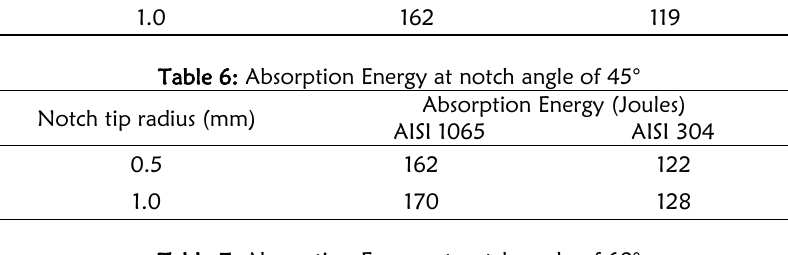
Table 7: Absorption Energy at notch angle of